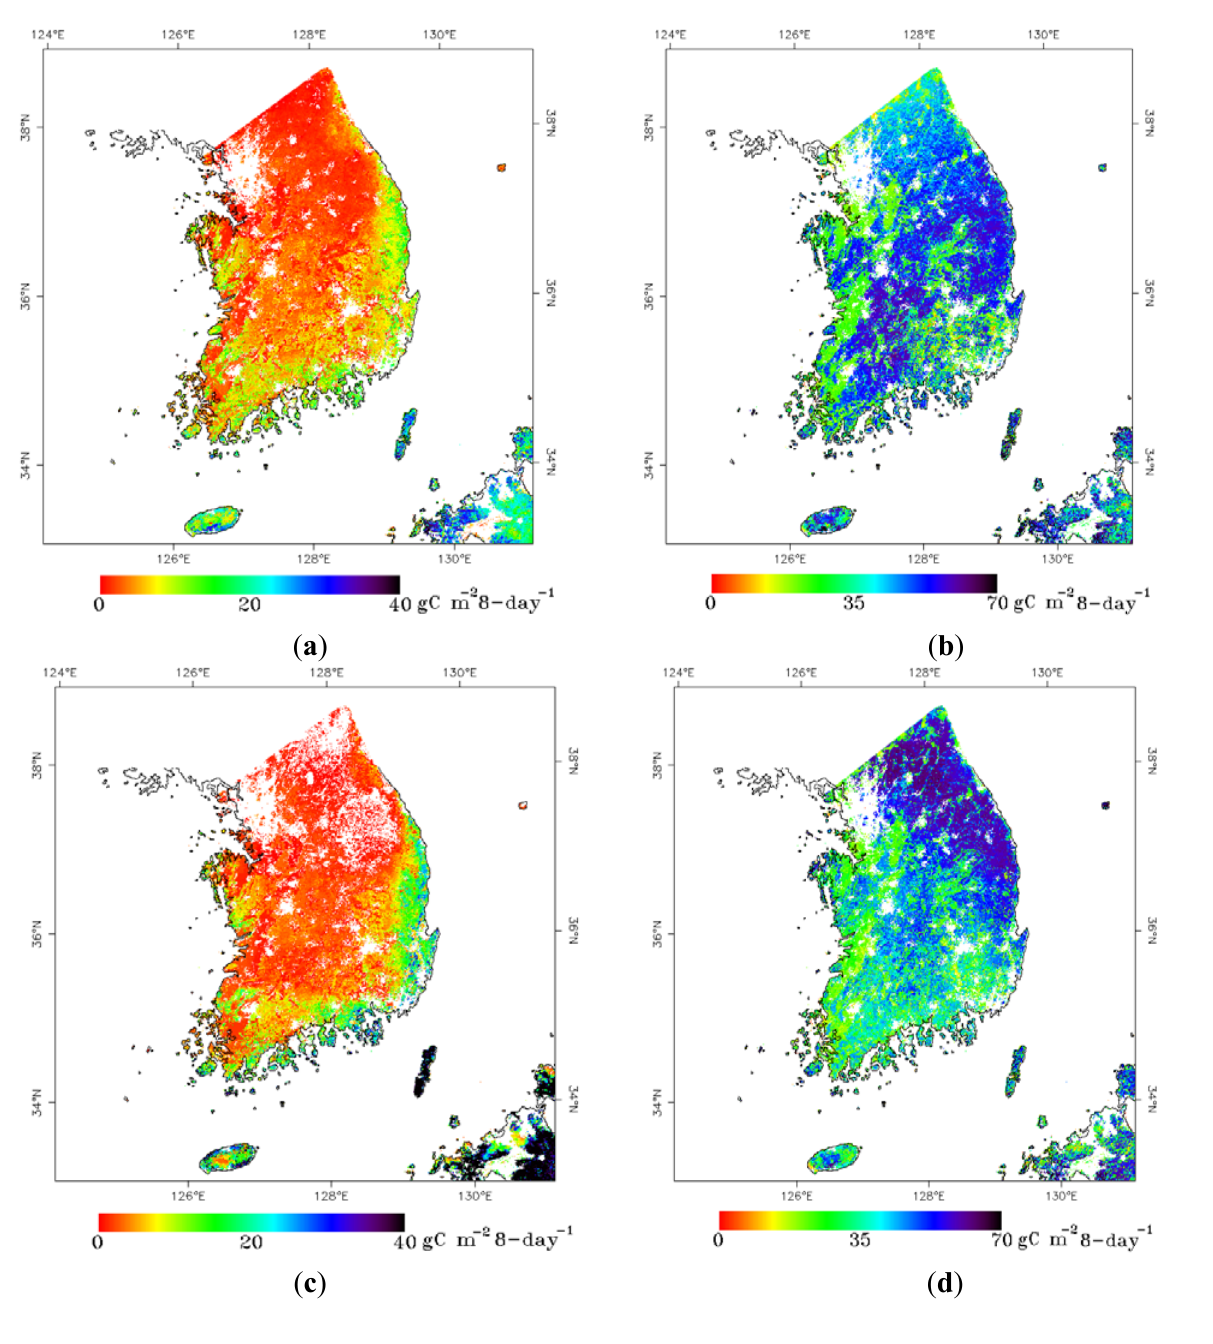
Figure 6. Spatial distribution of GPP in South Korea. ( a ) 17–24 January 2007. ( b )